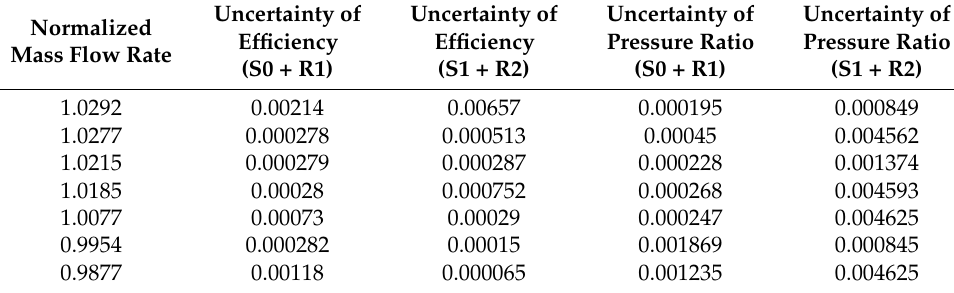
Table 1. The uncertainty of performance